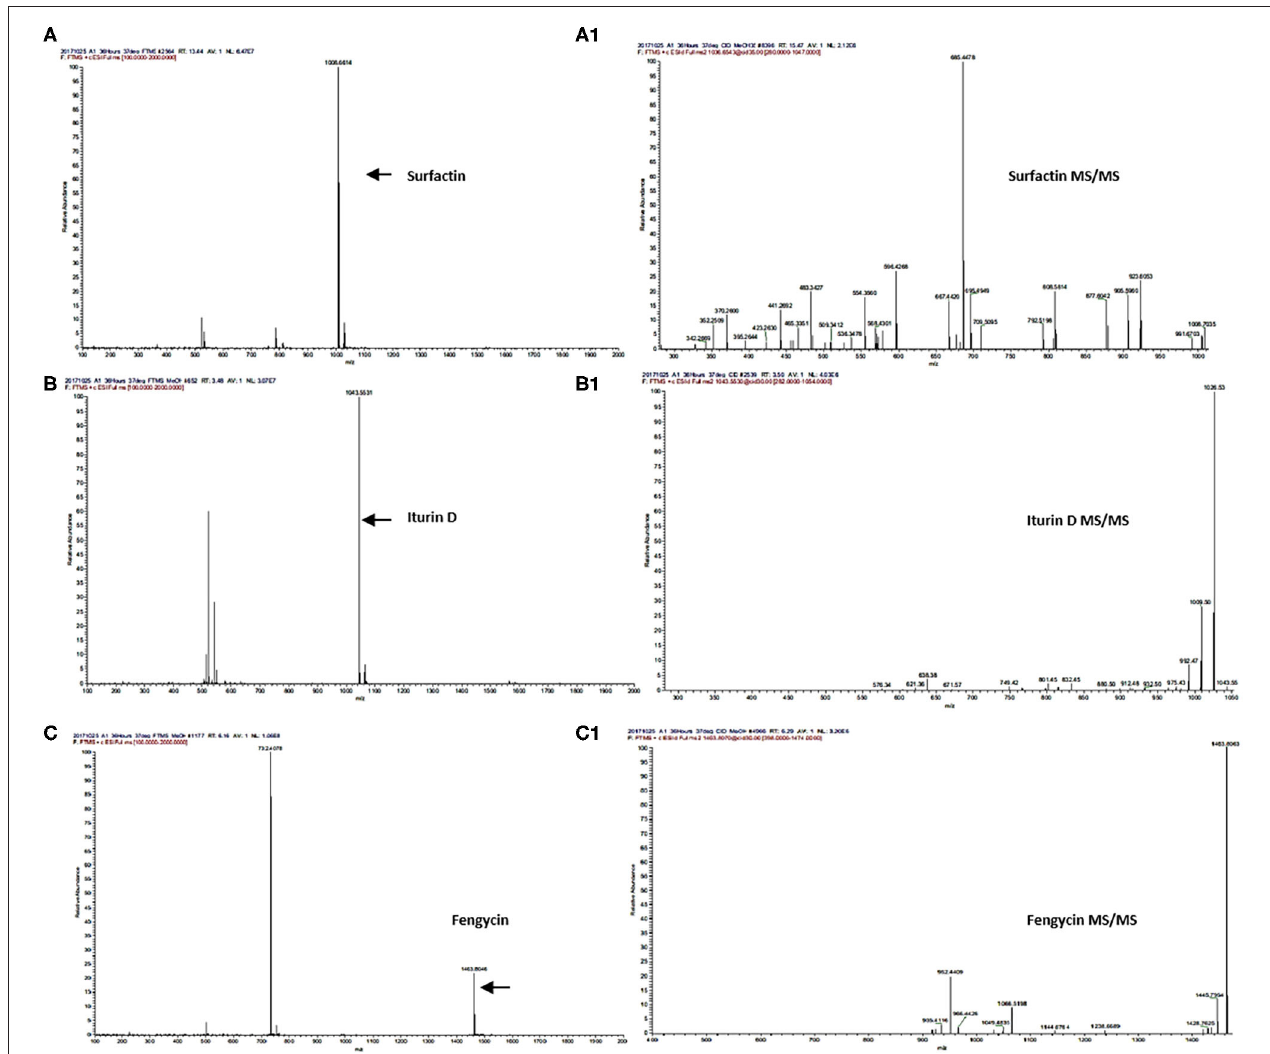
FIGURE 2 | UPLC-MS/MS chromatograms of surfactin (A,A1) , iturin (B,B1) , and fengycin (C,C1) , molecular ion-species detected in Bacillus spp. in positive ion-mode.